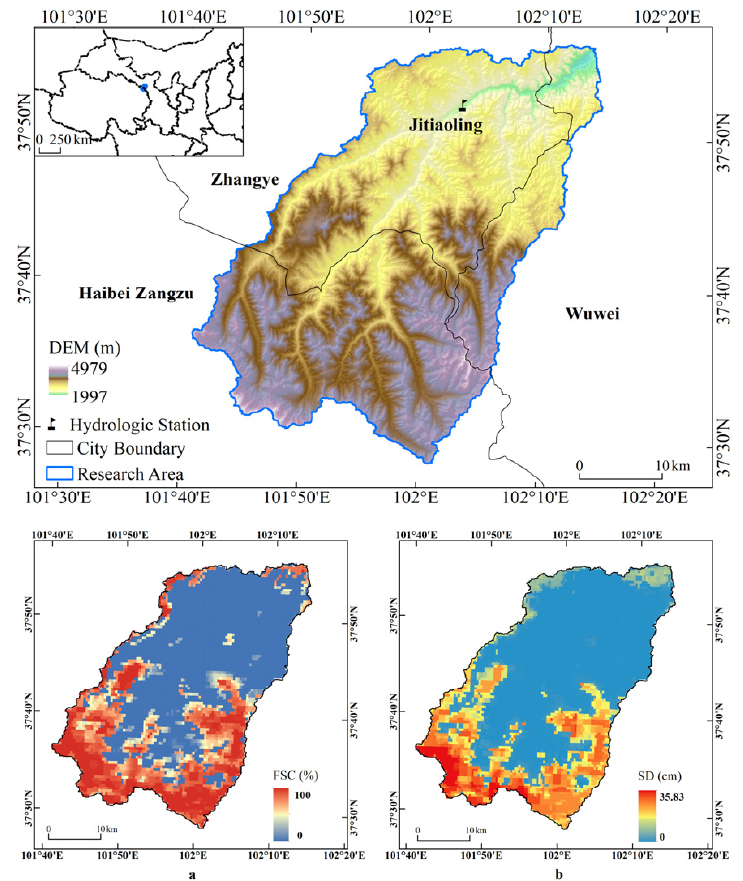
Figure 1. Research area overview, with a product diagram of SSE-mod FSC snow cover ( a ) and SDD-mod SD snow depth ( b ) data in the research area (1 January 2013).